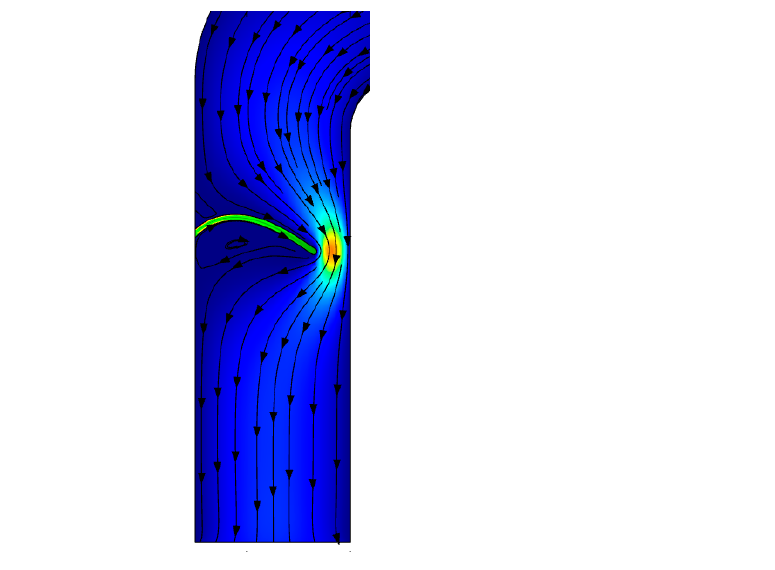
Figure 7. Variation of the obtained flow rate with the valve length ( h p ) for three valve widths (w); ( L p = 5mm, V = 400 V).